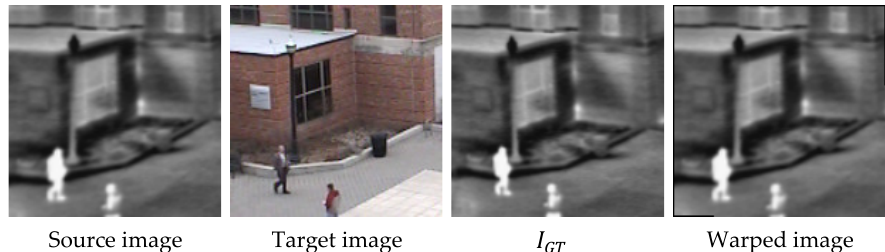
Figure 7. The resulting warped image results from the transformation of the source image by the homography matrix. Column 1 represents the source image. Column 2 represents the target image. Column 3 represents the infrared image form corresponding to the target image. Column 4 repre- sents the warped image.